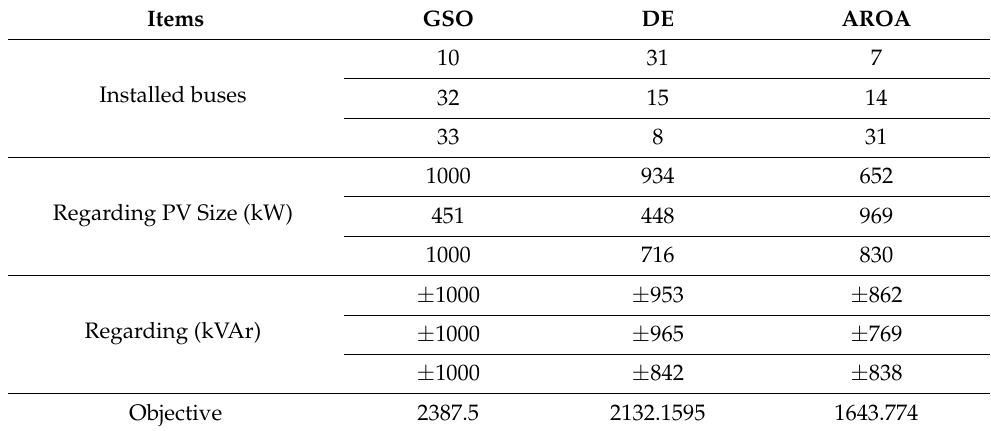
Figure 12. Convergence characteristics of DE and the AROA for the third scenario for the IEEE 33-distribution system. Table 3. Allocations of PV with STATCOM for the third scenario for the IEEE 33-distribution system .